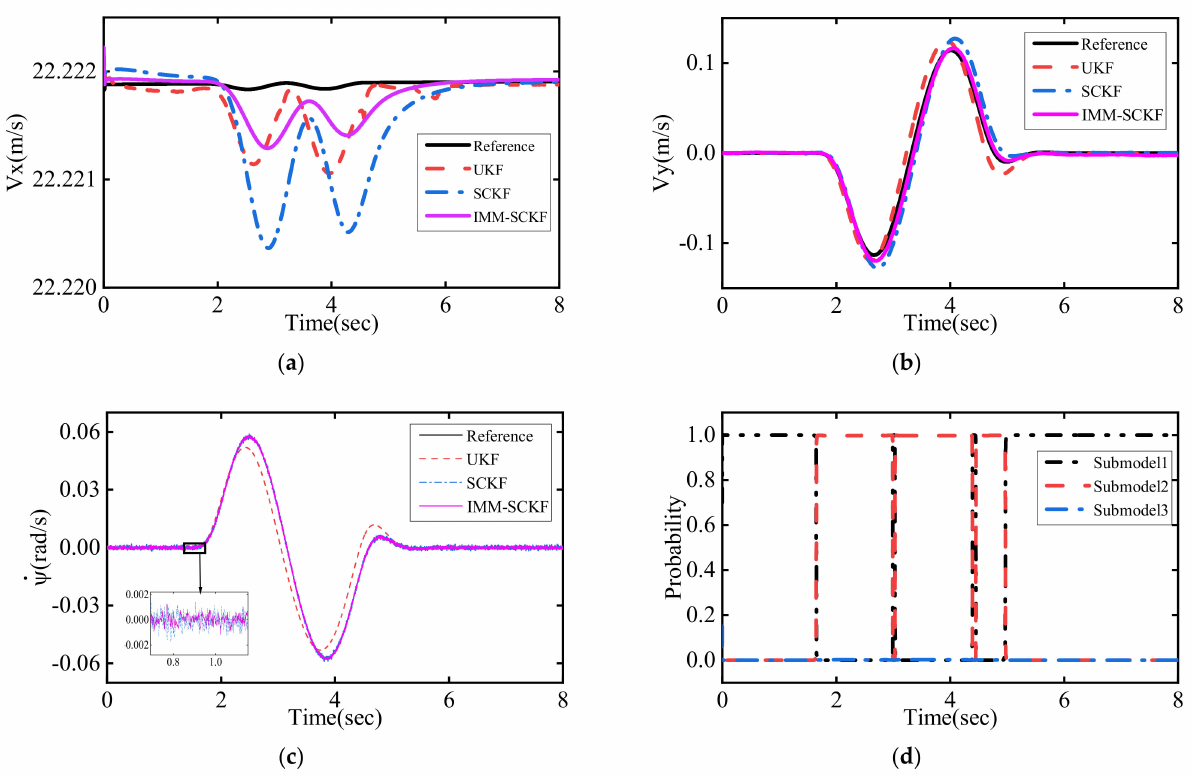
Figure 7. Simulation results of vehicle state under sinusoidal steering condition: ( a ) longitudinal velocity; ( b ) lateral velocity; ( c ) yaw rate; ( d ) probability of each IMM’s